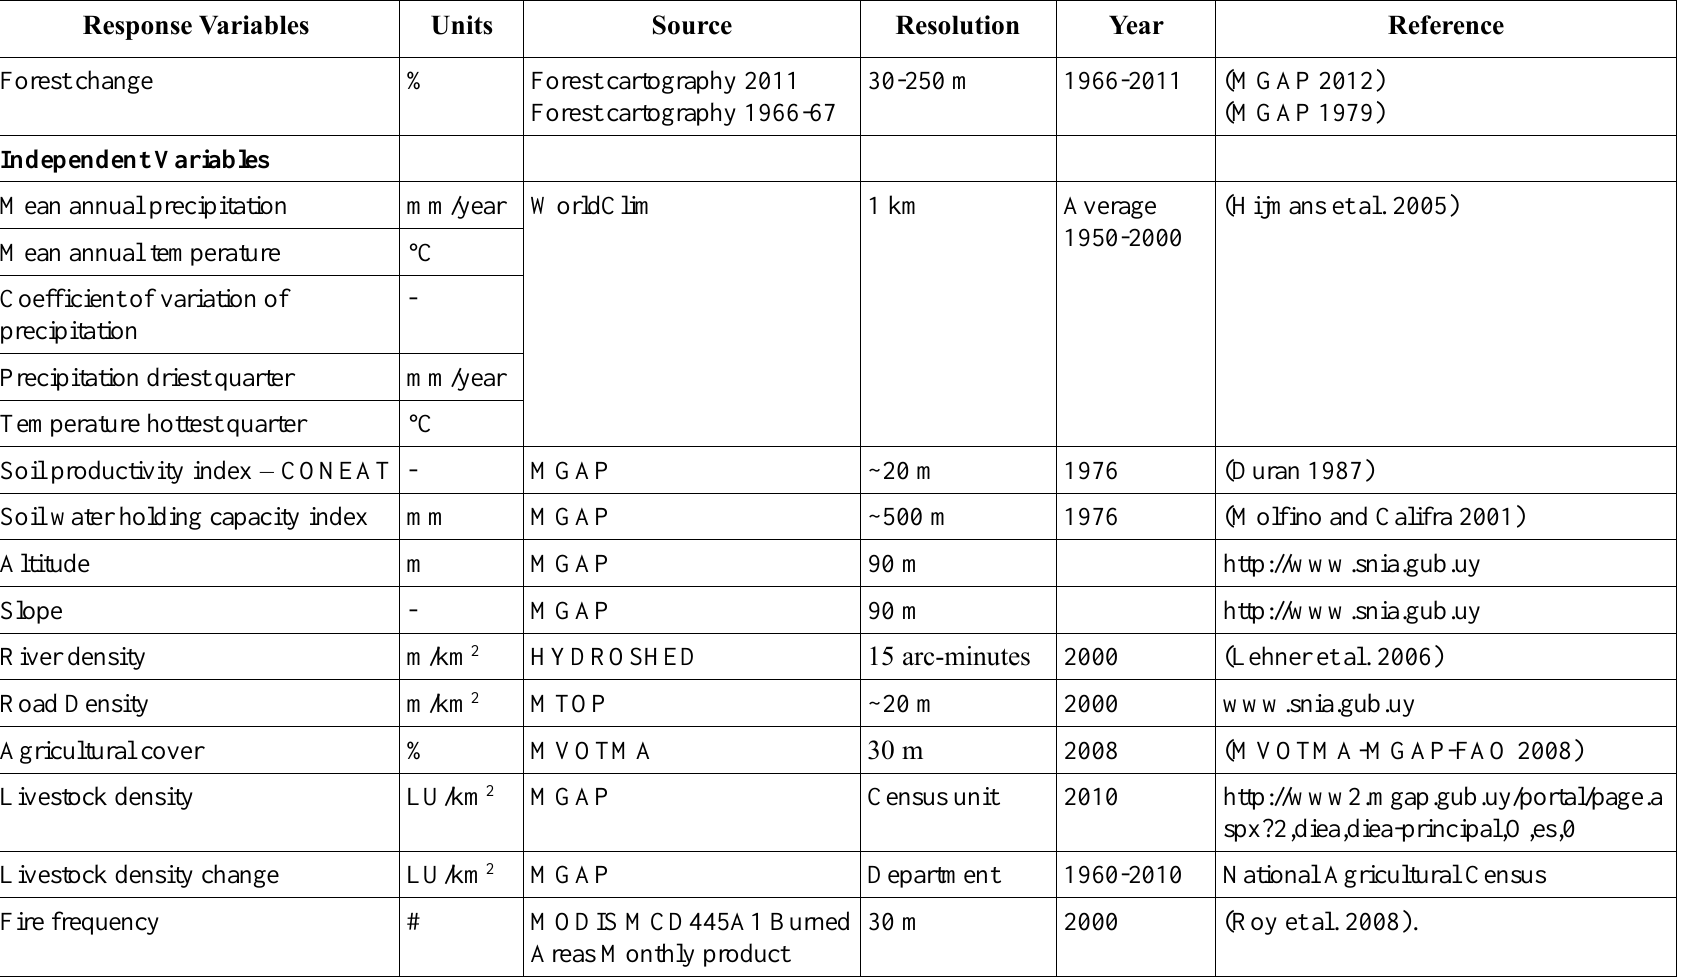
Table A1.1. Environmental and socio-economic variables used in statistical